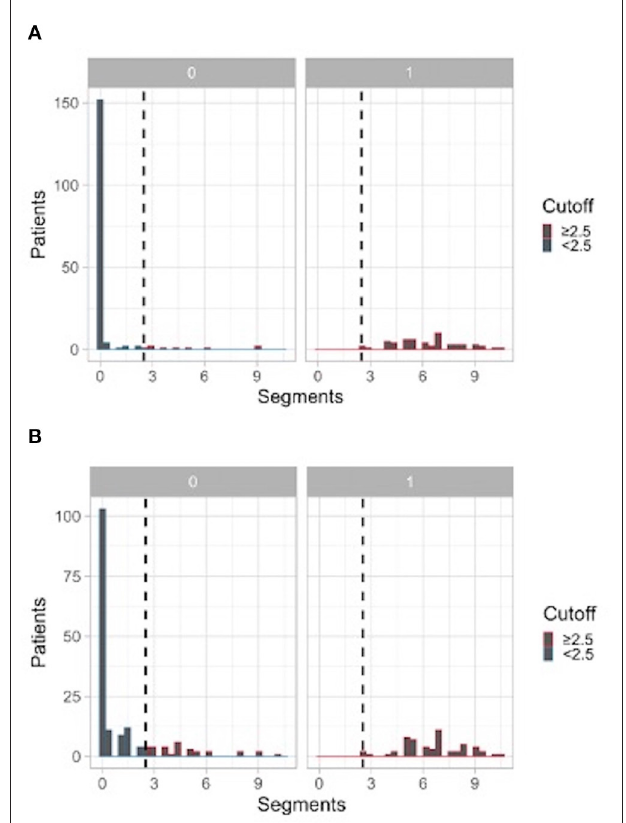
FIGURE 2 | (A) Segmental mismatched perfusion defects. (B) All segmental perfusion defects (regardless of ventilation). Red points: Cut-off at 2.5 segmental; Blue points: Cut-off at 1 segmental; Black points: Cut-off at 0.5 segmental.